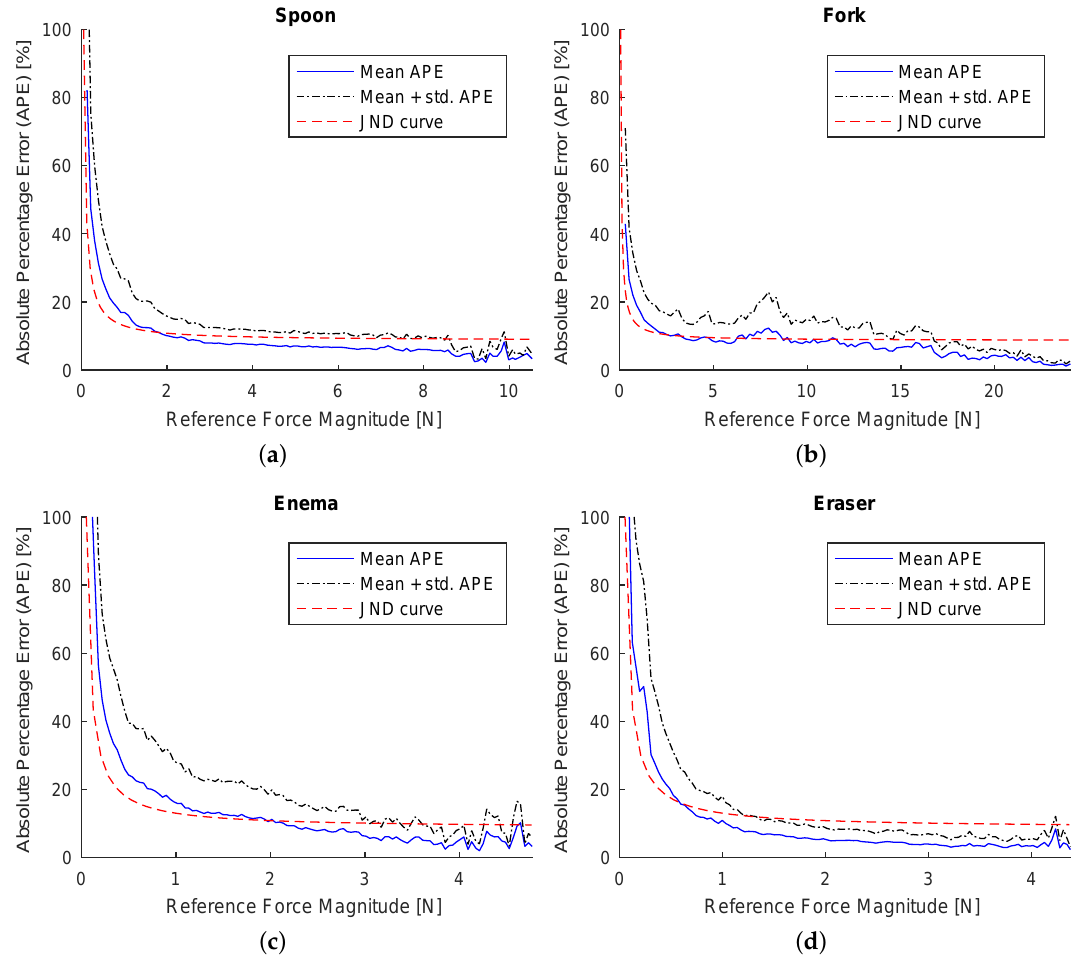
Figure 6. Relative error of the approximated signals for four datasets. The value of the relative error is expressed by absolute percentage error, which denotes the ratio of the force error magnitude to the magnitude of the reference force. The JND curve was computed based on data from psychophysical study in [50]. ( a ) Relative error for Spoon dataset; ( b ) Relative error for Fork dataset; ( c ) Relative error for Enema dataset; ( d ) Relative error for Eraser